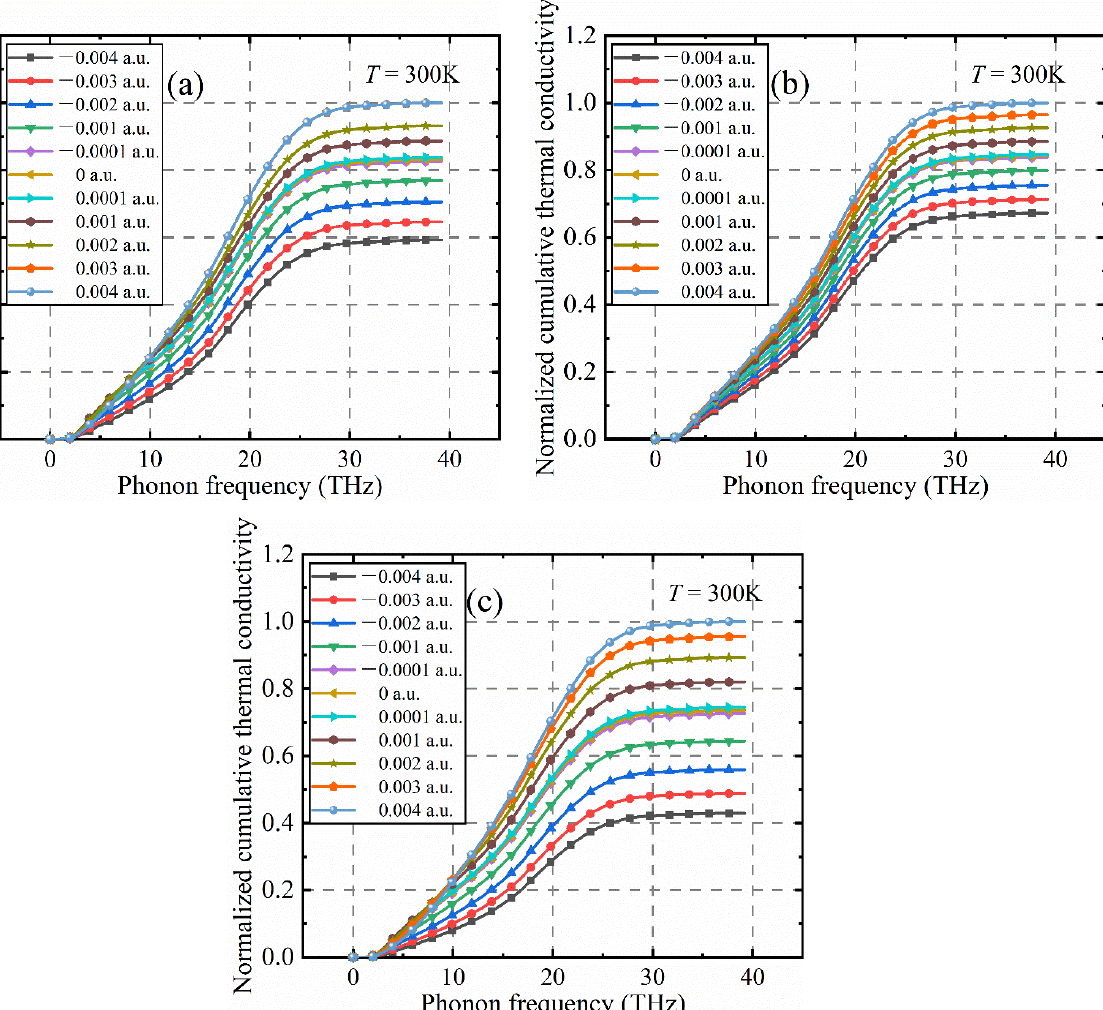
Figure 13. Frequency-normalized cumulative lattice thermal conductivity of diamond phonon: ( a ) positive and negative electric fields are applied to the [001] orientation, ( b ) positive and negative electric fields are applied to the [110] orientation and ( c ) positive and negative electric fields are applied to the [111] orientation. (T = 300 K).